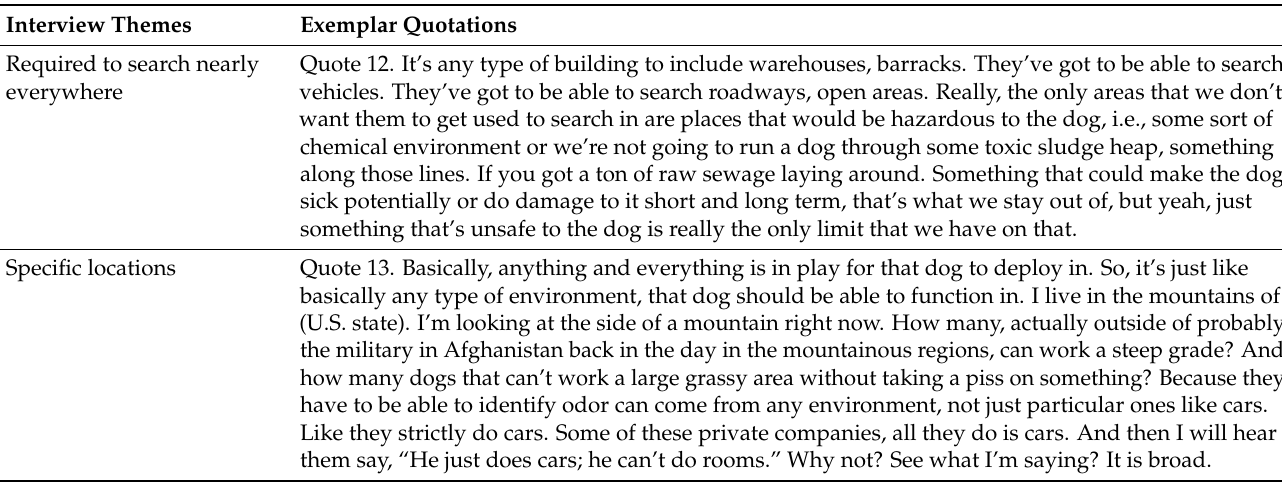
Table 3. Physical environment interview themes and exemplar quotations.